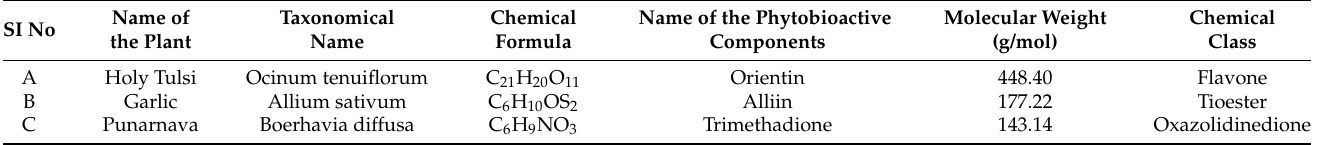
Table 2. Major plant derived phytobioactive constituents with plant source, scientific name and molecular